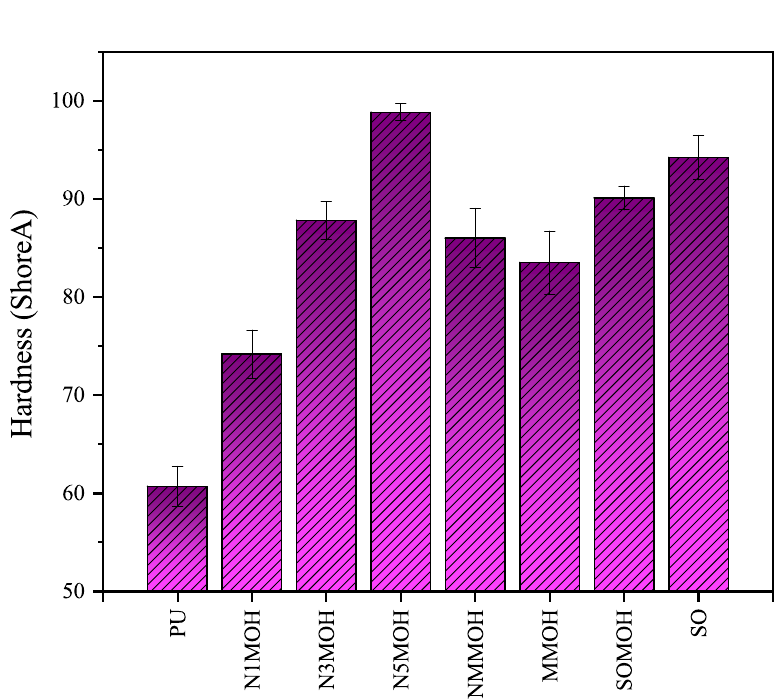
Figure 9. Comparison of hardness values on the Shore A scale of the nano-, micro-, and hybrid PU composite. Hardness was improved due to the presence of the SnMOH, mMOH, and SO hard particles inside the soft PU